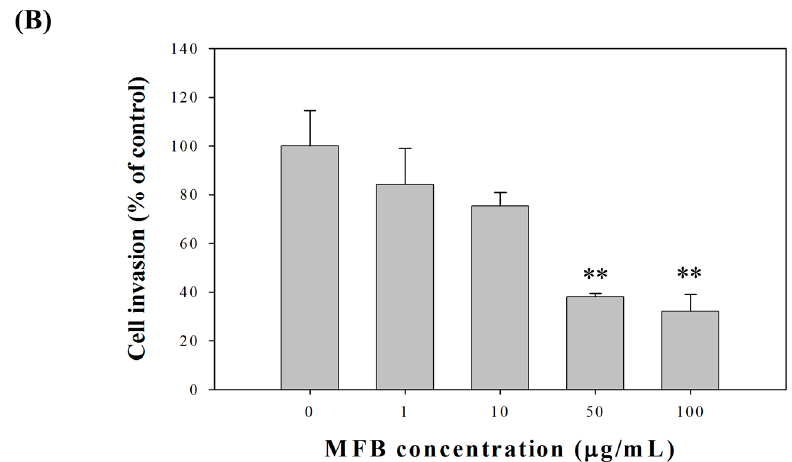
Figure 3. Effects of MFB on cell invasion of SK-Hep-1 cells. Cells (5 × 10 4 ) were incubated with MFB (1–100 µg/mL) for 24 h. Representative phase contrast photomicrographs (100× magnification) were taken at 24 h ( A ) and invasion ability was quantified ( B ) by counting the number of cells that invaded to the underside of the membrane. Values are means ± SD, n = 3; significant difference from control value was indicated ** p < 0.01.